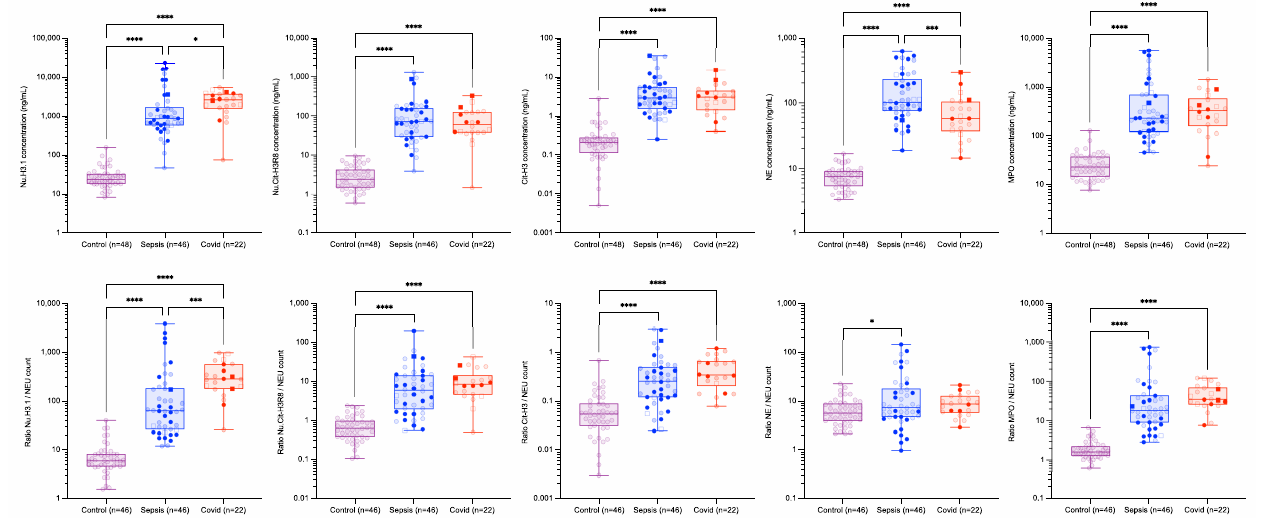
Figure 1. Levels of circulating nucleosomes and neutrophil activation biomarkers in control, septic shock and critical COVID-19 populations. Nu.H3.1, Nu.Cit-H3R8, Cit-H3, NE and MPO were compared. Results are expressed as absolute value or normalized by neutrophils level for each individual. All markers were statistically different in septic shock and critical COVID-19 compared to controls. Only Nu.H3.1 and NE were different between septic shock and critical COVID-19 patients. Boxes represent 25th – 75th percentile with median. Whiskers represent min to max variation. Squares represent patients with a thromboembolic event, and non-transparent symbols represent dead patients. *, *** and **** represent p - values ≤ 0.05, ≤0.001 and ≤0.0001, respectively. Only differences that are sta tistically significant are reported. Abbreviations: Cit-H3, citrullinated histone H3 (citrullinated in R2, R8 and R17); MPO, myeloperoxidase; NE, neutrophil elastase; Nu.Cit-H3R8, citrullinated H3R8-nucleosome; Nu.H3.1, H3.1-nucleosome.